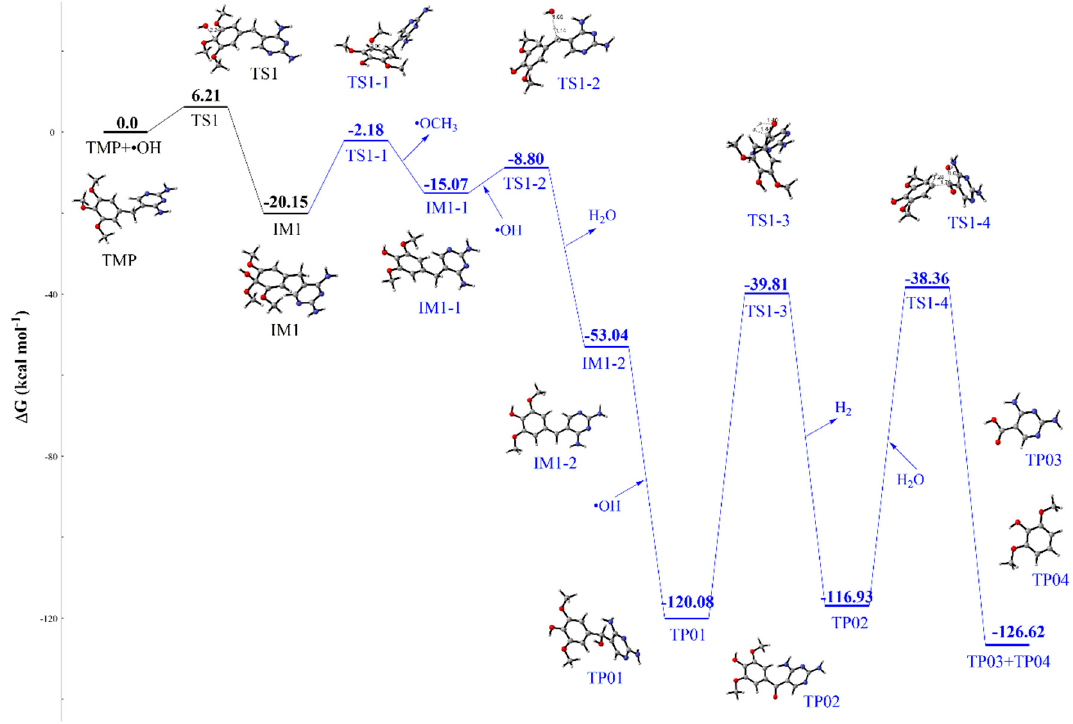
Figure 6. Schematic diagram of free energy for the subsequent reactions of IM1 during the Figure6. SchematicdiagramoffreeenergyforthesubsequentreactionsofIM1duringthetransformation transformation of TMP at the M06-2X/6–31+G (d, p) level. of TMP at the M06-2X / 6–31 + G (d, p)